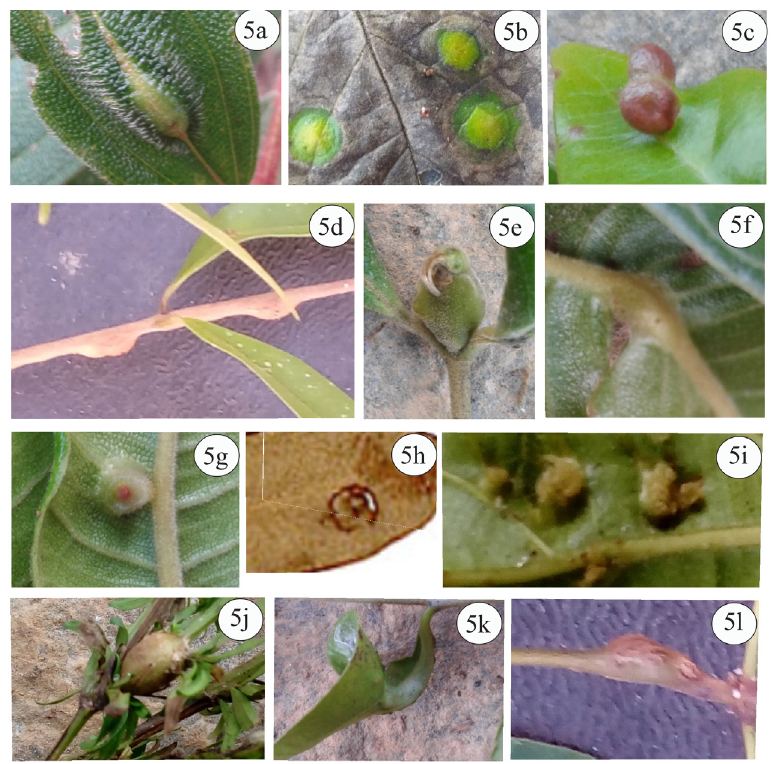
Figure 5. a-l. Insect galls found in the Serra Negra do Funil Natural Heritage Private Reserve (MG, Brazil). 5a, on Tibouchina sp. (Melastomataceae), leaf midvein gall, 5b, on Ficus enormis Mart. ex. Miq. (Moraceae), leaf gall, 5c-g, on Myrtaceae, 5c, on Eugenia uniflora L., leaf gall, 5d-g, on Myrcia splendens (Sw.) DC., 5d, stem gall, 5e, bud gall, 5f, leaf midvein gall, 5g, leaf